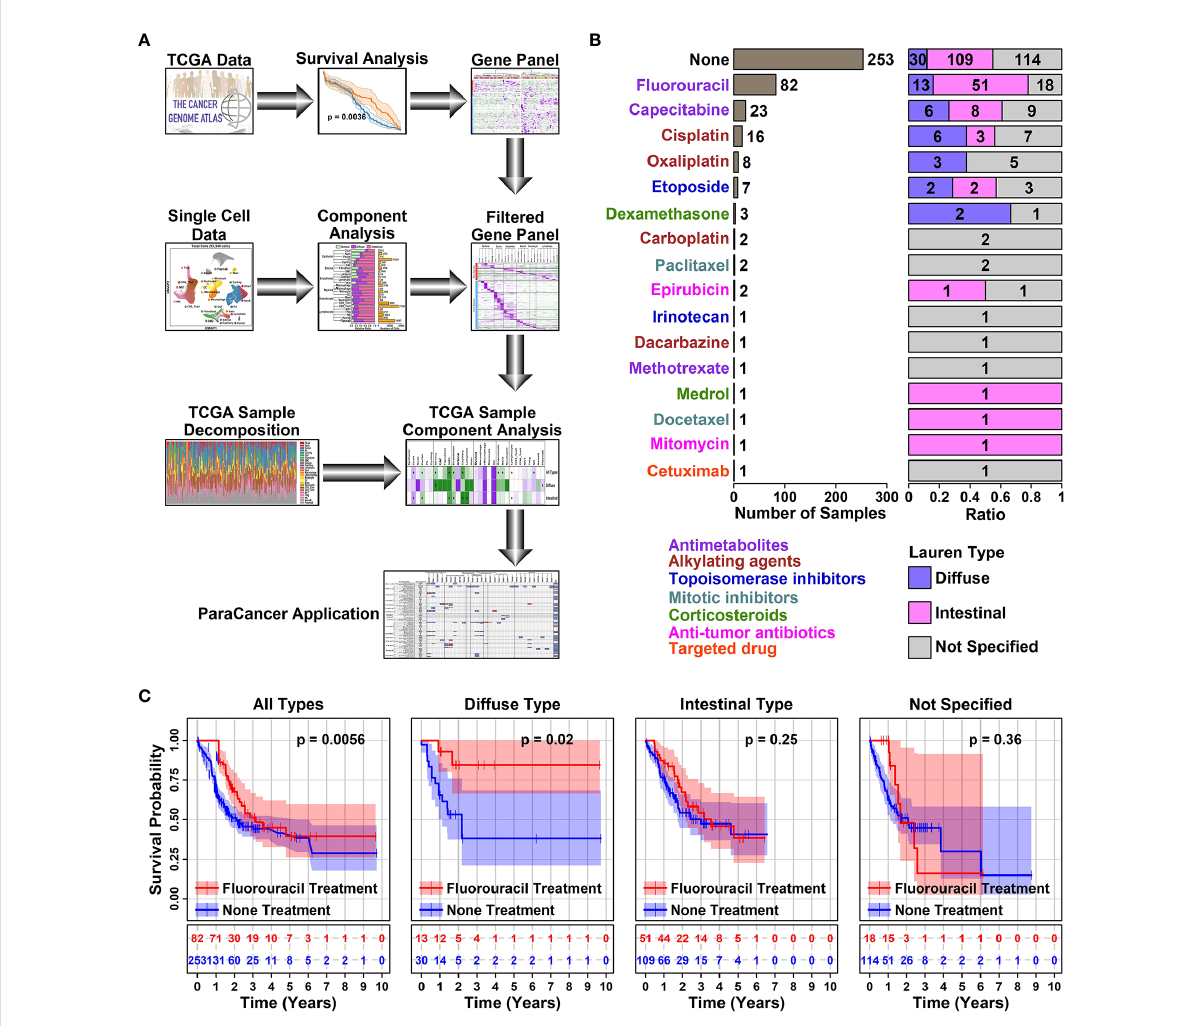
FIGURE 1 5-FU responses in different subtypes of STAD samples. (A) Schematic diagram illustrating the research design of this study. In this study, a Pro and Con gene panel was fi rst screened using TCGA data, and the expression status of these genes was further examined in different cell types of GC samples using scRNAseq data. inally, the conclusions of this study were validated using decomposited TCGA data; (B) Bar plot showing the number of samples with a certain type of drug treatment. All the STAD sample information was retrieved from TCGA online database; (C) Plots showing the survival status of patients with or without 5-FU treatment. The survival information of involved STAD samples was retrieved from the TCGA database, and a Kaplan-Meier plotter was used to estimate the survival information. A p < 0.05 was used as a signi fi cance